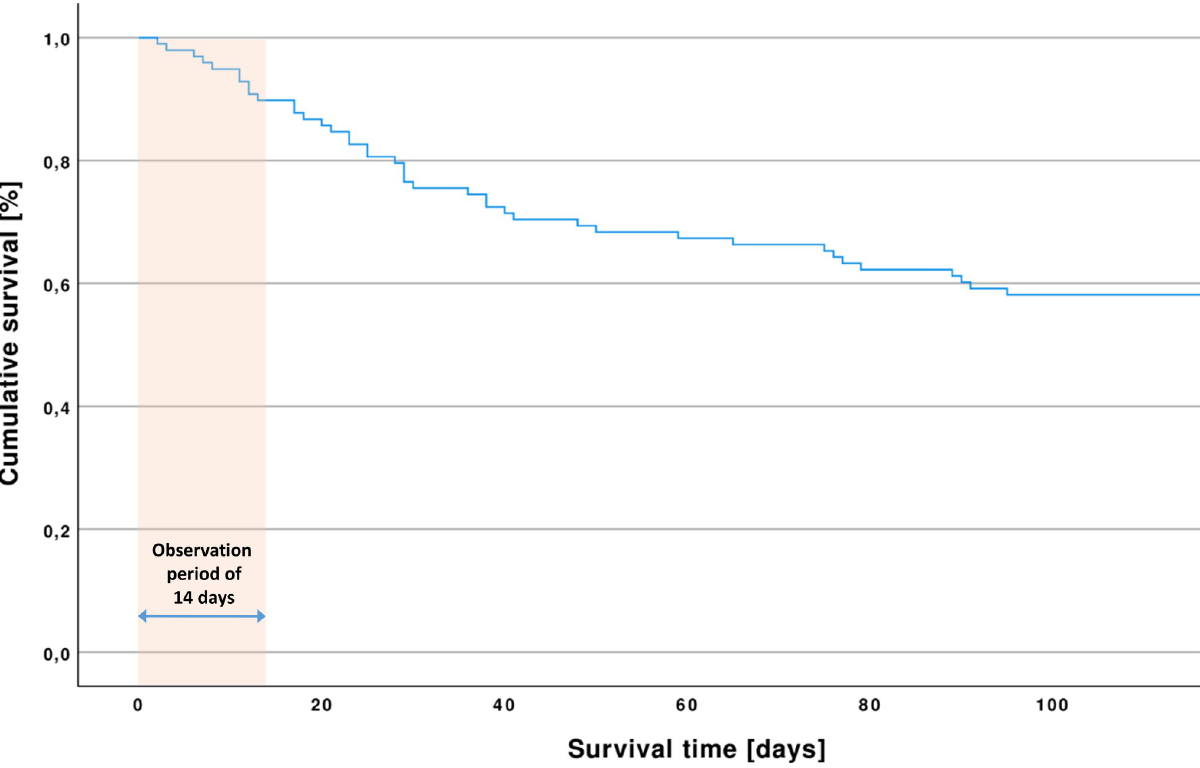
Fig 1. Kaplan-Meier estimator for all patients of the second-wave cohort. Out of 98 patients included in the study, 41 did not survive. 10 patients had died within the observation period of the first 14 days of intensive care treatment, and 57 patients were discharged from the intensive care unit.